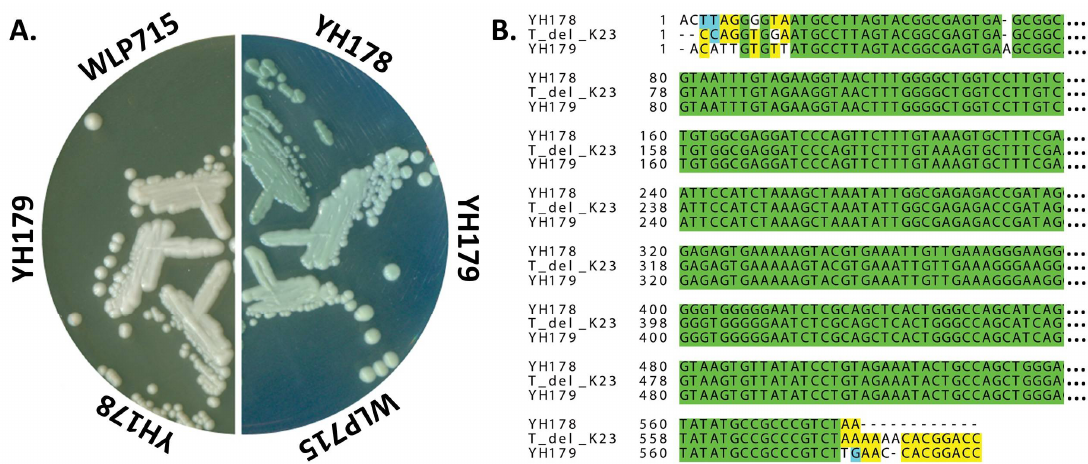
Figure 1. YH178 and YH179 are both strains of T. delbrueckii . ( A ) Colony morphology of YH178, YH179, and S. cerevisiae WLP715 on YPD (left) and WLN (right) agar plates. The indicated strains were streaked for single colonies and grown at 30 °C for 2 days prior to capturing images of the plates with a flatbed scanner. ( B ) Sequence alignments revealed that YH178 and YH179 are isolates of T. delbrueckii . A portion of the 26S rDNA of YH178 and YH179 was PCR-amplified and sequenced, and the sequences are aligned to the closest related strain in the NCBI nucleotide database. T_del_K23 denotes the 26S rDNA gene of T. delbrueckii strain K23 (GenBank accession KP852445.1). The ellipsis at the end of each line represents the missing sequence that was truncated due to spatial constraints. The full alignment is shown in Figure S1. Green: fully conserved; yellow: conserved among two sequences; blue: similarity (pyrimidines); dashes: sequence gaps due to indels.